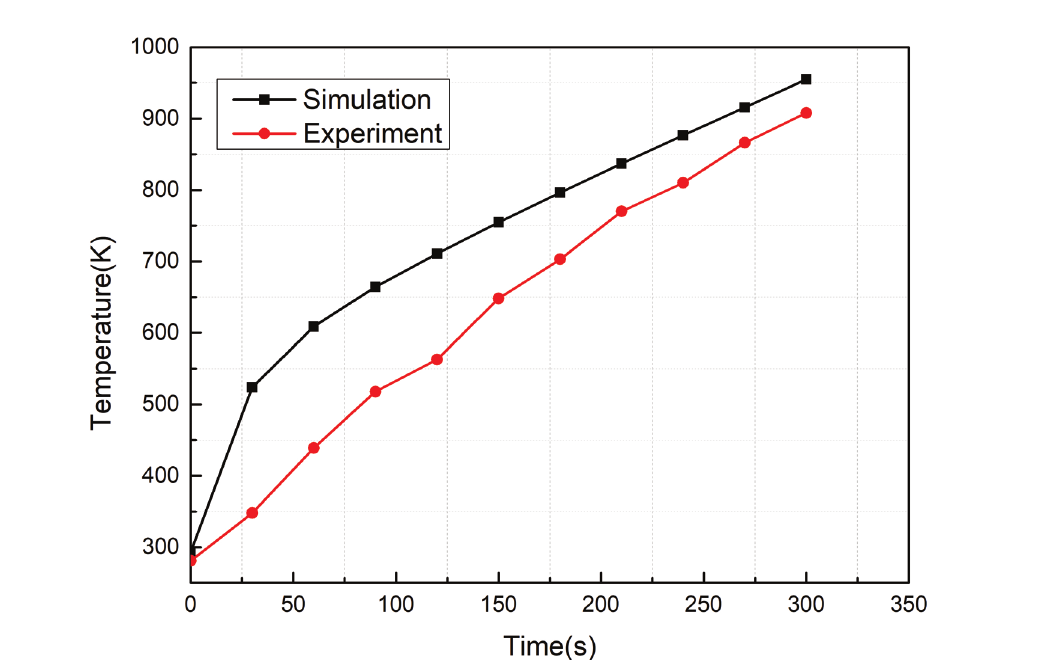
Figure 9: Comparison of the experimental and simulated temperature evolution of Y-TZP, at h = 340